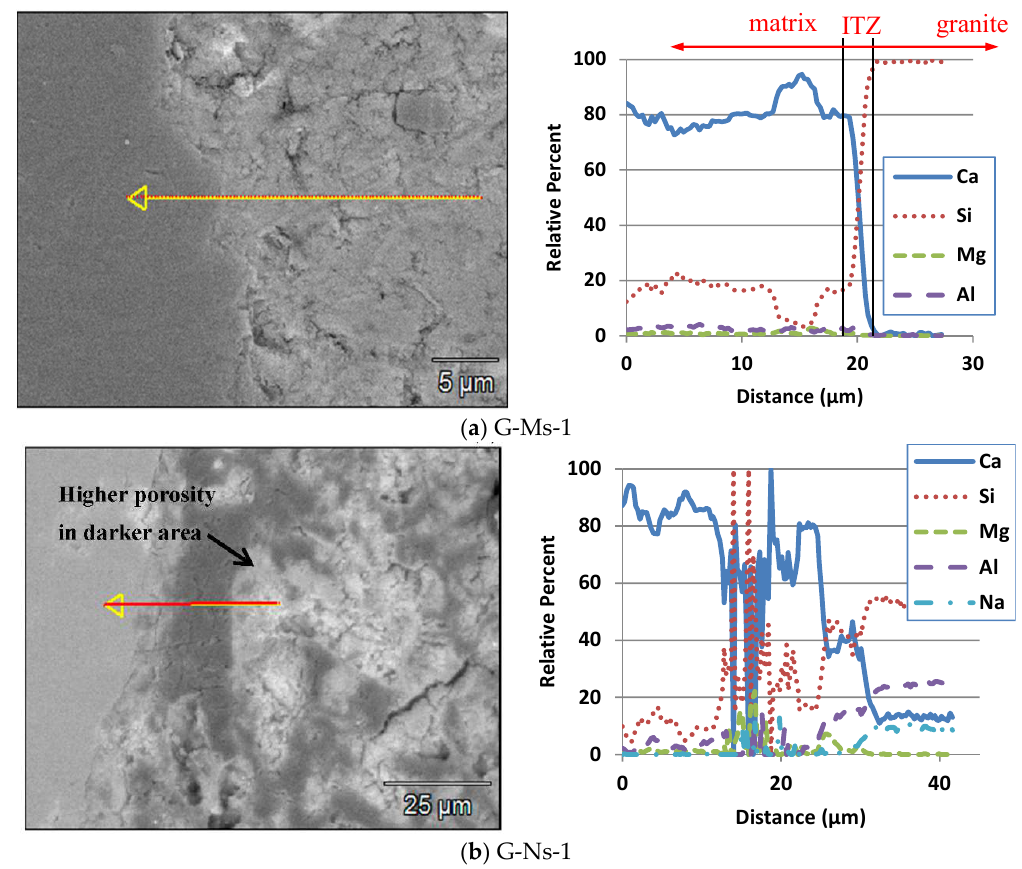
Figure 12. Line scanning analyses (SEM and EDX) of interfacial transition zone (ITZ) regions for granite concrete mixtures.